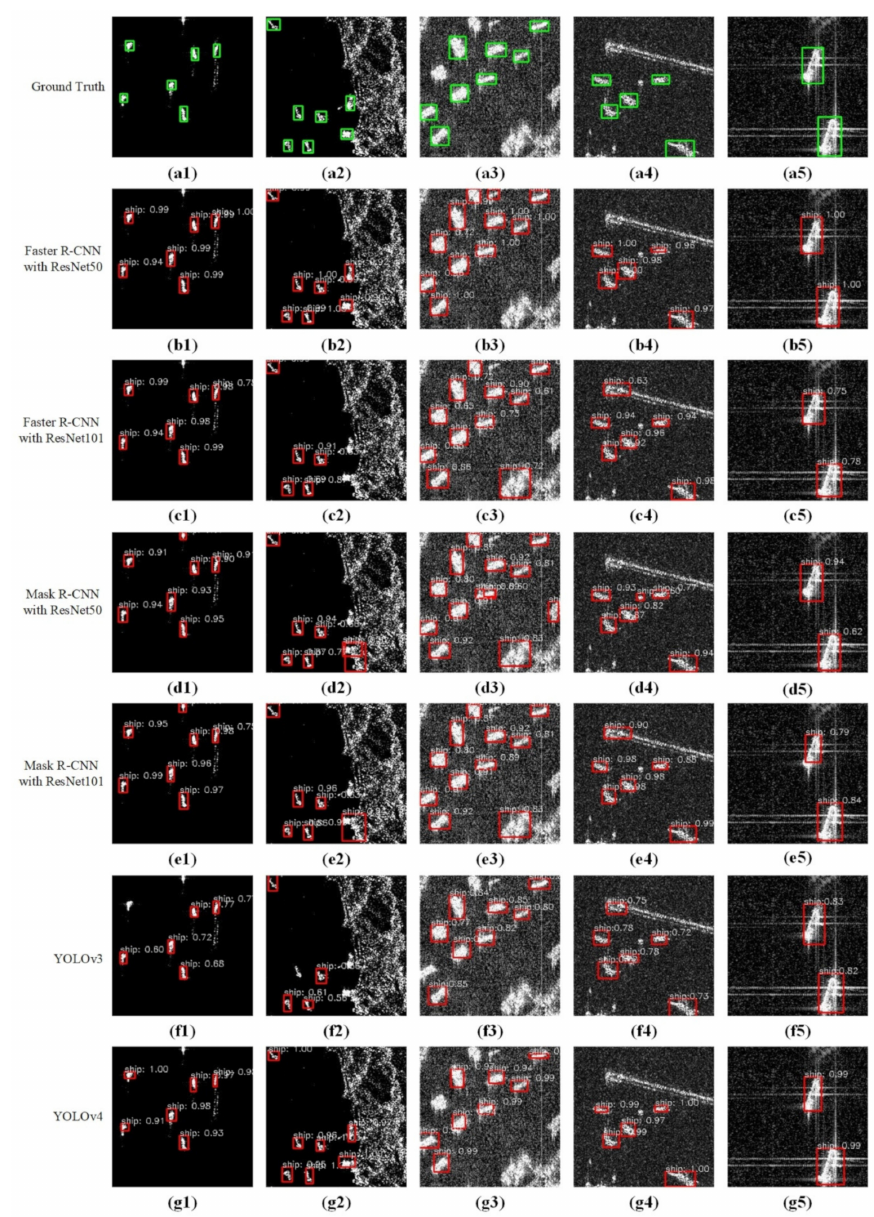
Figure 8. Experimental results in SAR-Ship-Dataset. ( a1 – a5 ) The first row contains ground truth images. ( b1 – b5 ) The second row contains the results of Faster R-CNN with ResNet50. ( c1 – c5 ) The third row contains the results of Faster R-CNN with ResNet101. ( d1 – d5 ) The fourth row contains the results of Mask R-CNN with ResNet50. ( e1 – e5 ) The fifth row contains the results of Mask R-CNN with ResNet101. ( f1 – f5 ) The sixth row contains the results of YOLOv3. ( g1 – g5 ) The seventh row contains the results of